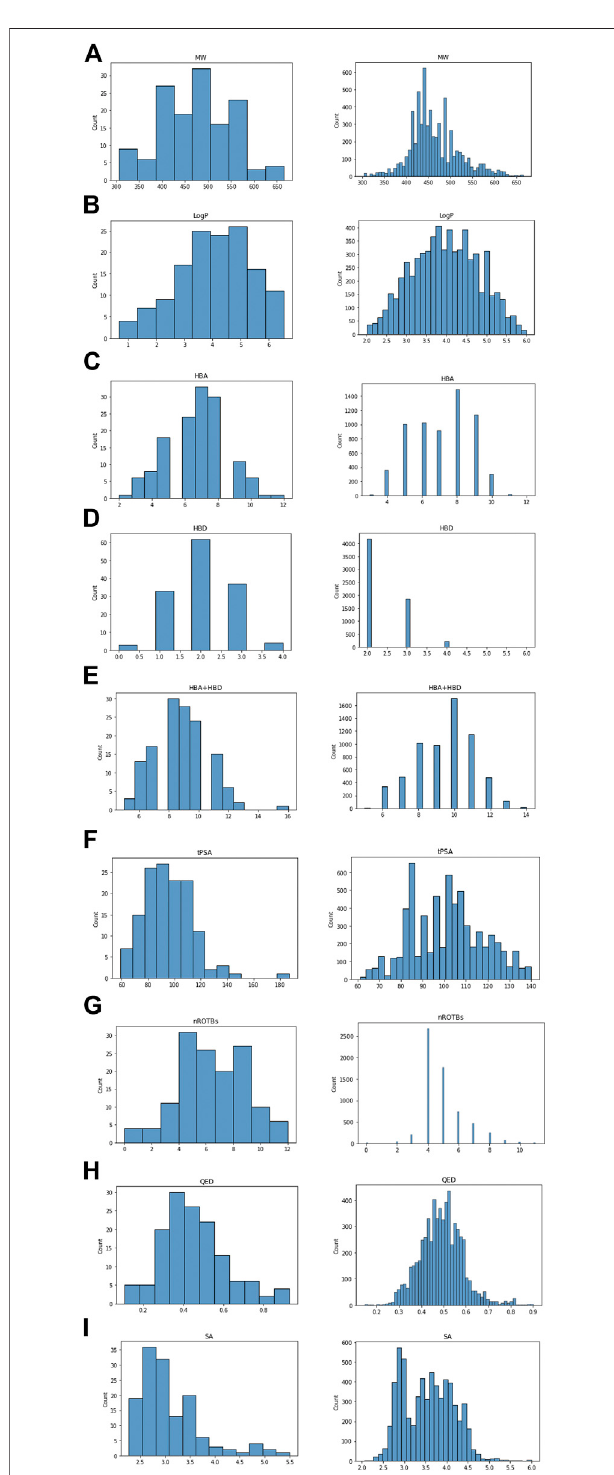
FIGURE 3 | Comparison parameter distribution of ‘ − tinib ’ and 6,283 ligands made by AI. The fi gure shows the parameter distribution, the ‘ − tinib ’ on the left and the AI generated ligands on the right. (A) Molecular Weight, (B) LogP, (C) HBA, (D) HBD, (E) HBA+HBD, (F) tPSA, (G) Rotatablebond, (H) QED, and (I) SA (Synthetic Accessibility)